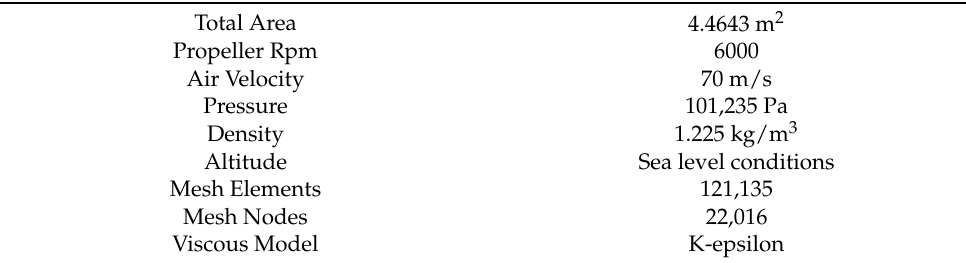
Figure 25. Propeller 3D model. Table 15. Boundary conditions for thrust calculations. Table 15. Boundary conditions for thrust calculations.